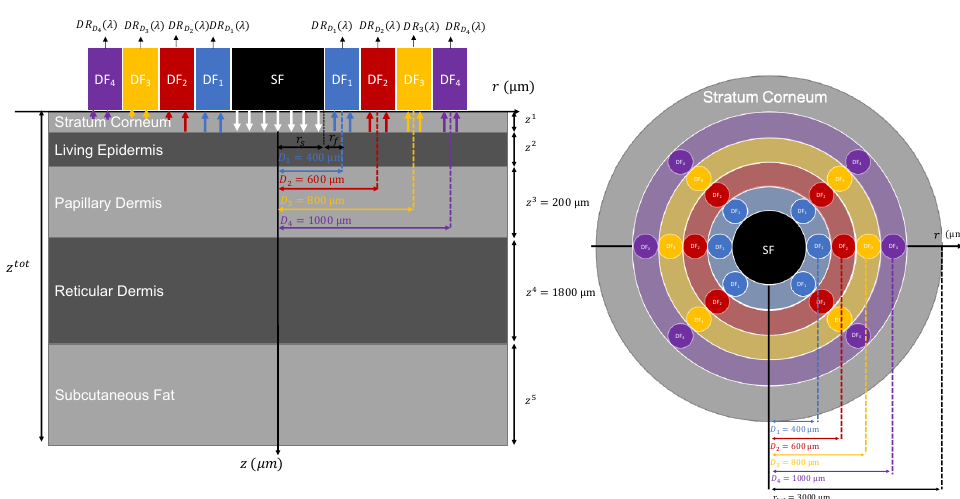
Figure 1. Schematic representation of the SR-DRS fiber probe geometry and of the five-layer skin implemented for simulations: vertical section view ( left ) and top view ( right ). SF, DF and ( λ ) stand for Source Fiber, Detection Fiber and Diffuse Reflectance spectrum at the distance D n DR D n ( n ∈ { 1,2,3,4 } ),